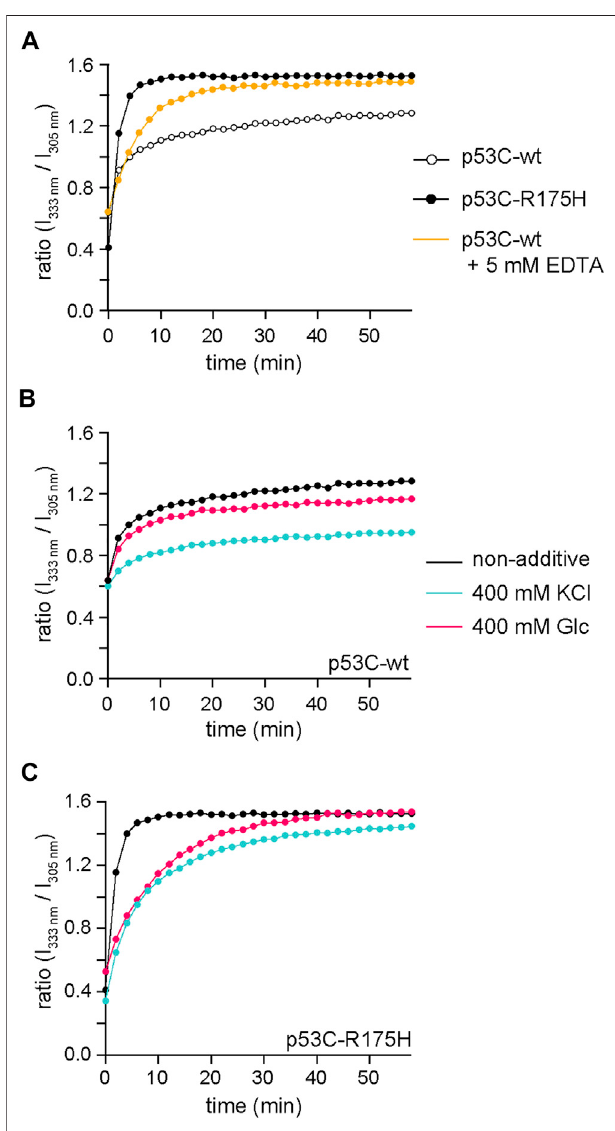
FIGURE 5 | The structural transition was monitored from the ratio of the fl uorescence intensity at 333 – 305 nm when excited at 280 nm. (A) Time courseoftheratioofthe fl uorescenceintensityat333 nmtothatat305 nmfor p53C-wt without additives (black, open circle), p53C-wt with 5 mM EDTA (yellow), and p53C-R175H without additives (black, solid circle). (B,C) Time course of the ratio of the fl uorescence intensity at 333 nm to that at 305 nm for p53C-wt (B) and p53C-R175H (C) without additives (black), with 400 mM KCl (cyan), and with 400 mM Glc (magenta). The data for non- additives are identical to those for Panel (A) and have been redrawn for